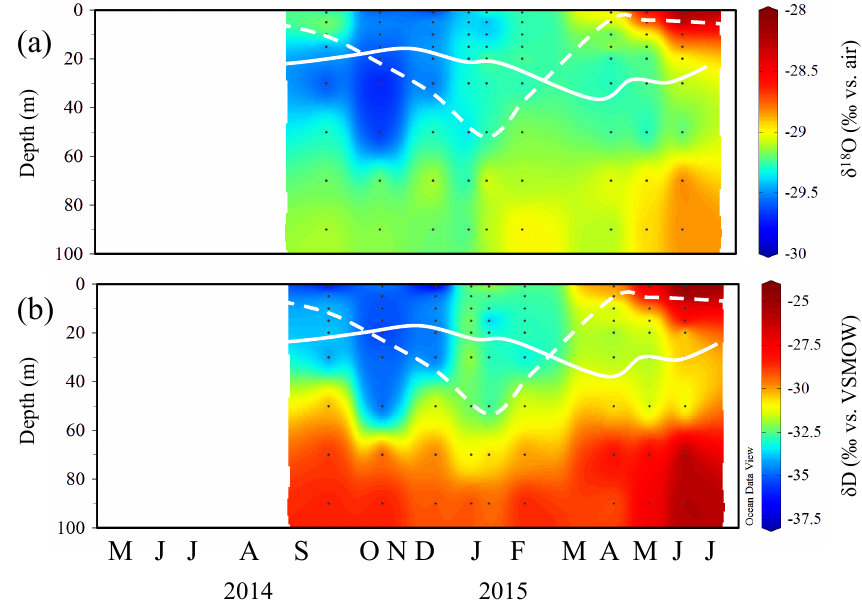
Figure 3. Seasonal variability in (a) δ 18 O of water O 2 (‰ vs. air) and (b) δD (‰ vs. VSMOW). Solid white line indicates the limit of euphotic zone and dashed white line the depth of mixed